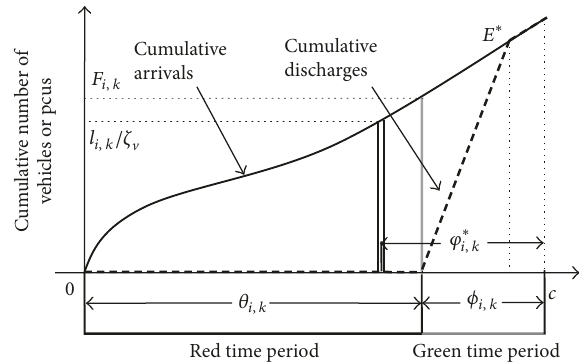
Figure 6: Typical traffic signal settings for overflowing approach lane 𝑘 from leg 𝑖